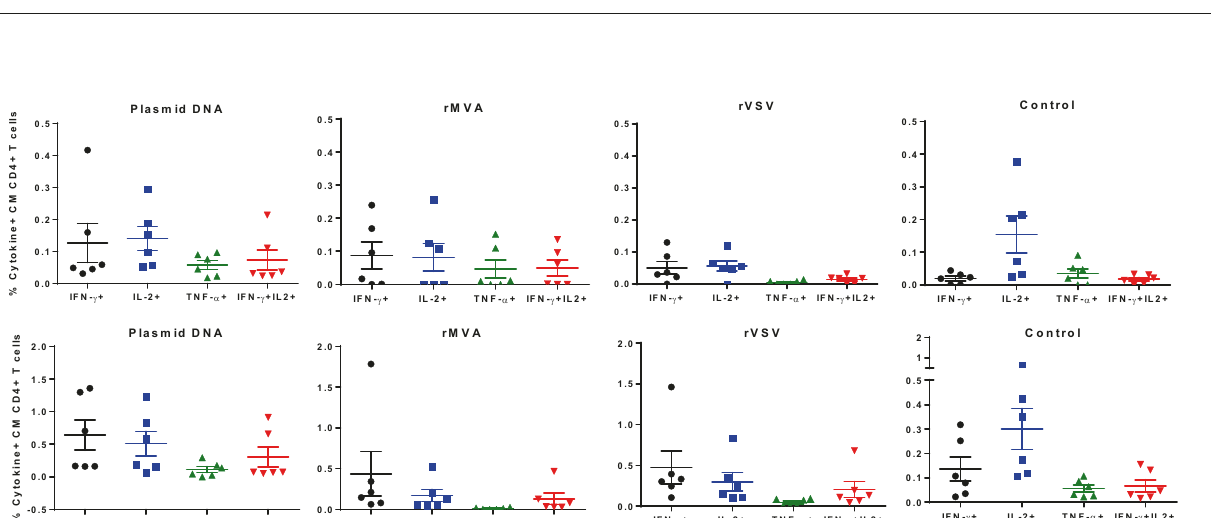
Fig. 1 Antibody responses elicited by different priming immunizations. Neutralizing antibody responses as measured by TZM-bl cell-based assay at pre-immune, week 0 ( a ) and post-boost, week 32 ( b ) time points. TZM-bl cell-based neutralization assays were performed against both Tier 1 and Tier 2 viruses. Curve-based log ID50 values for pre-immunization and post-protein boost time points are shown for plasmid DNA (green circles), rMVA (red triangles), and rVSV (lavender diamonds), and protein only control (orange squares) groups. ID50 titers against seven different viruses, HIV-1 SF162, BG1168.1, 92RW020.5, TV.21, HIV-MN.3, MW965.26, and HIV-SS1196.01 are shown with geometric mean with 95% CI of the six monkeys per group. c Binding antibody titers elicited by different priming immunizations. ELISA binding titers (log AUC) of plasma against autologous (upper panels) and heterologous (lower panels) antigens from individual monkeys in four vaccine groups are shown at Week 2 (black symbols), Week 10 (green symbols), and post-boost (red symbols) time points. The lines indicate the median of the six monkeys per group.